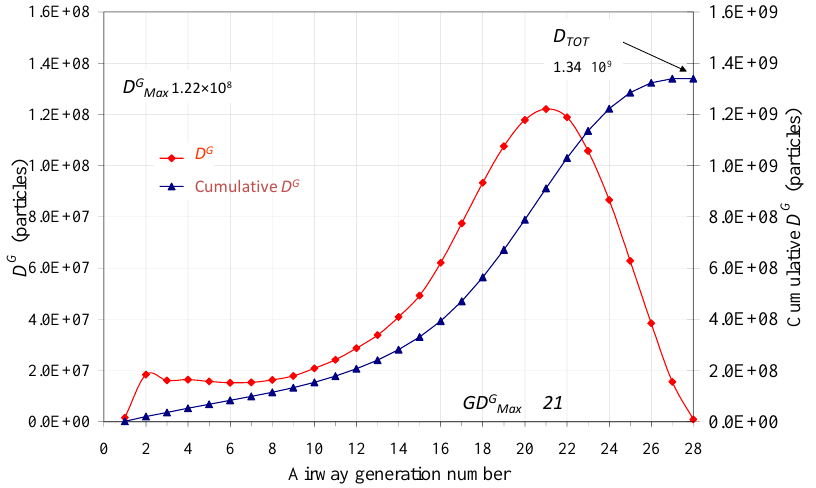
Figure 8. Dose deposited ( red ) for each generation and cumulative deposited dose ( blue ) during a single welding process ( D G the total particle number dose deposited in the Gth generation; D G max the maximum dose per airway generation; D tot the total particle number dose deposited in the respiratory tree; GD G max the airway generation number at D G max ).